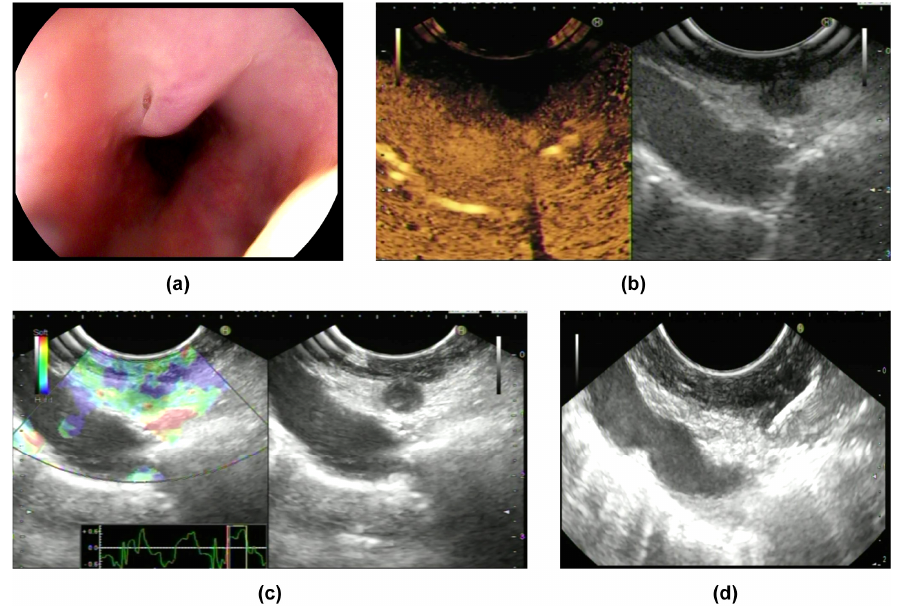
Figure 2. Manifestations of Case 2: ( a ) manifestations of the lesion according to EGD; ( b ) the lesion was hypo-enhanced according to CH-EUS; ( c ) the lesion was soft according to elastography; ( d ) EUS-FNA for the lesion.